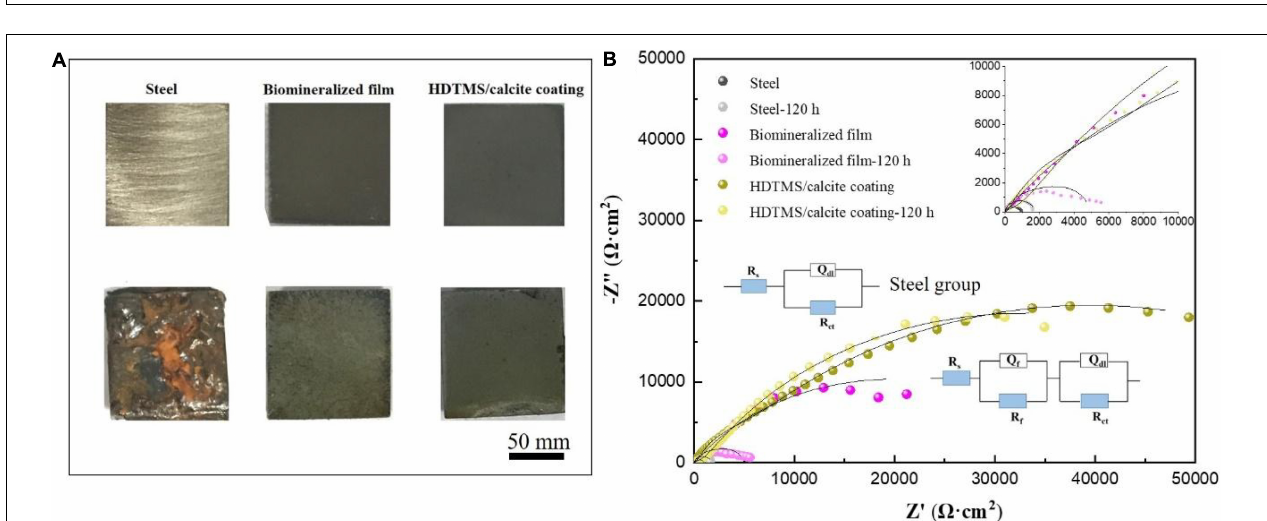
FIGURE 9 | Self-cleaning properties on (A) steel, (B) biomineralized film, and (C) HDTMS/calcite coating by using methylene blue and soil.